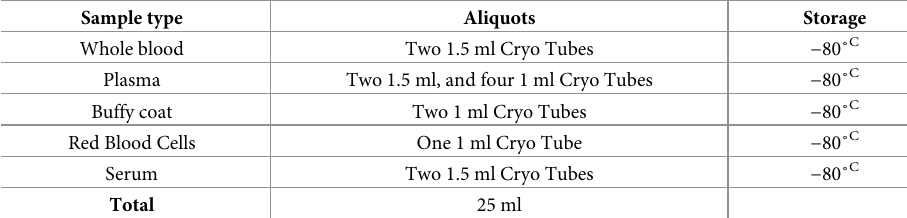
Table 3. Blood taken from each individual and